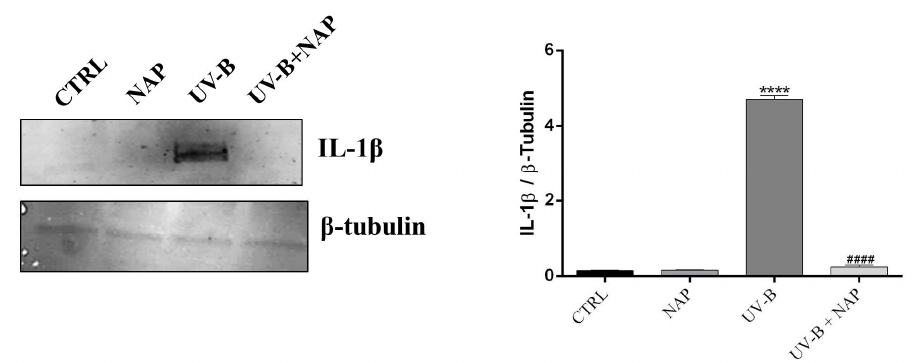
Figure 2. Effect of NAP treatment on IL-1 β expression in UV-B-irradiated corneal epithelial cells. Representative immunoblots of IL-1 β expression in SIRC cells cultured in either normal condition (CTRL) or with NAP (100 nM), or exposed to either UV-B alone (UV-B) or with NAP (UV-B+NAP). The bar graph shows a quantitative analysis of signals obtained by immunoblots resulting from three independent experiments. Data represent means ± SEM (**** p < 0.001 vs. CTRL; #### p < 0.001 vs. UV-B).